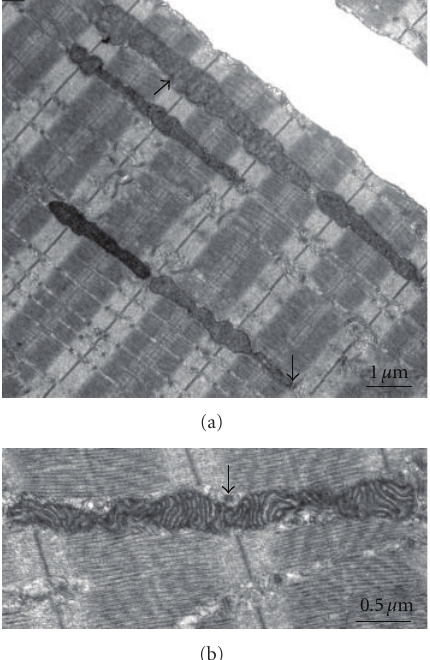
Figure 4: Longitudinal sections of leg muscles from a small lizard, as an example from reptiles. The myofibrils are small, and the CRUs (triads) are frequent, as expected from a rapid muscle. Mitochondria are not frequent, and they are located in single longitudinal rows between the myofibrils. An occasional proximity to CRU occurs when the mitochondria cross the T tubule network (arrows, see also Figures 3 and 5 for birds and